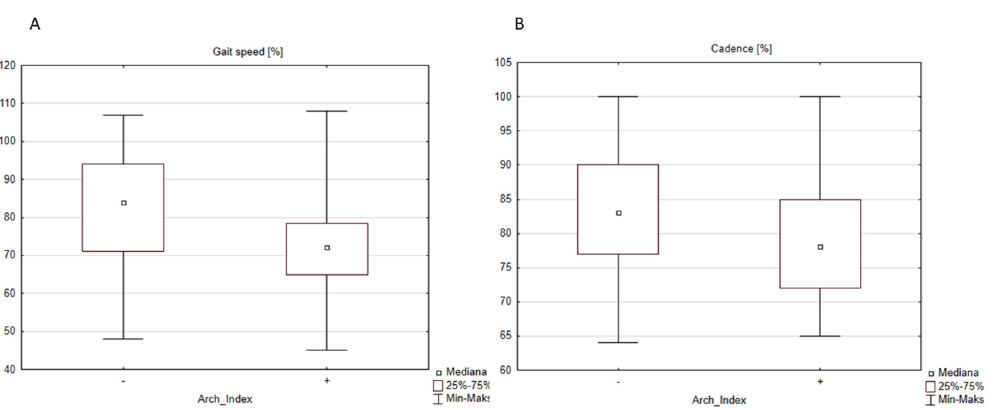
Figure 3. The influence of the type of the foot defined by the Arch Index on the spatio-temporal parameters: ( A ) speed, “-“—normal foot (median = 84.0%), “+” flat foot (median = 72.0%), and ( B ) cadence, “-“ normal foot (median = 83.0%), “+” flat foot (median = 78.0%).